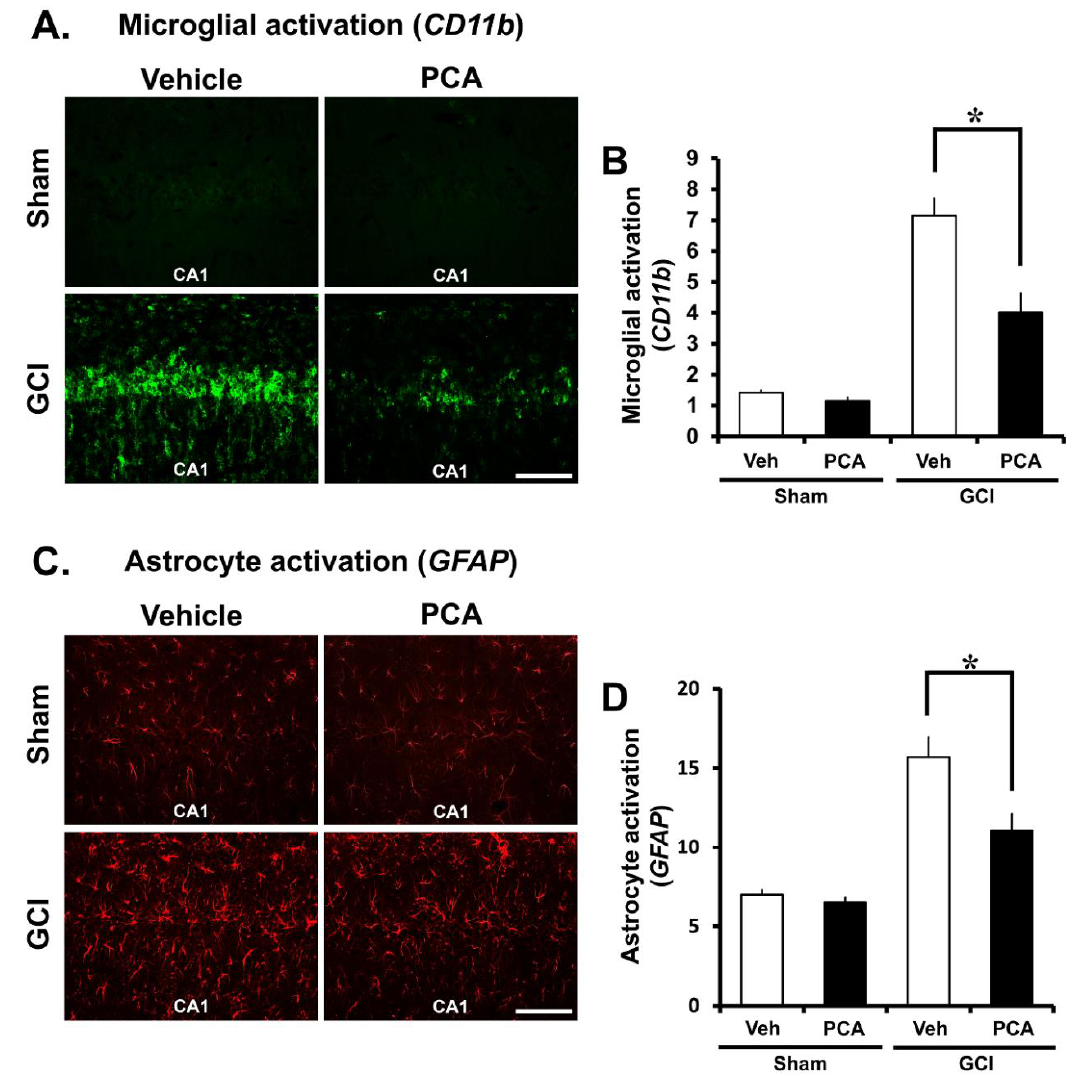
Figure 5. PCA treatment reduces microglia and astrocyte activation. Global ischemia induces an inflammatory response by promoting microglia activation and activated astrocytes, in the damaged region. In this figure, PCA treatment for one week prevents microglia and astrocyte activation in CA1 following global ischemia. ( A ) shows microglia activation and ( C ) shows astrocyte activation in the CA1 of hippocampus from sham-operated or ischemia-induced rats. It was increased in the ischemia-induced group in comparison to the sham-operated group. However, PCA administration prevented microglia and astrocyte activation in the PCA-treated groups after ischemia. Scale bar = 100 µm. ( B , D ) The bar graph represents the grade of microglia activation and the intensity of activated astrocytes in the CA1 region. Data reflect the mean ± S.E.M., n = 5 from each sham group. n = 9 from each ischemia group. p < 0.05.